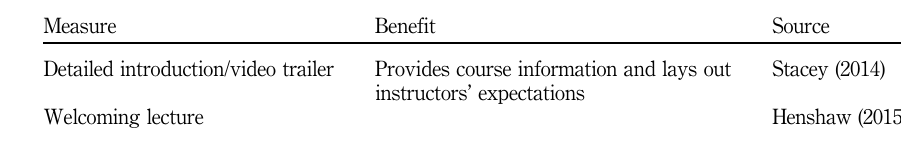
Table I. Ways to increase